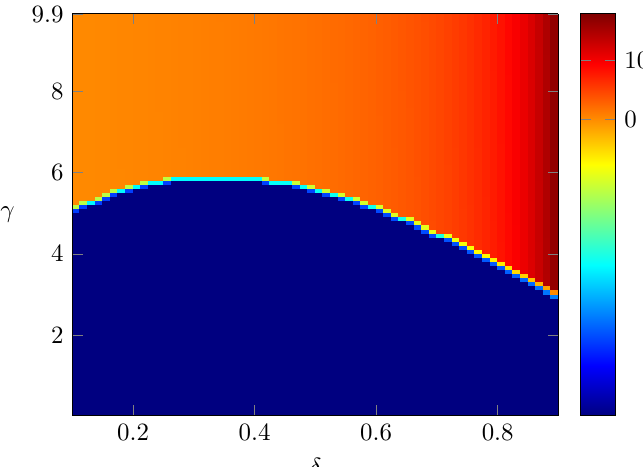
Figure 2. This shows C ∗ as a function of γ and δ . In the darker region in the bottom half of the plot, this is where ruin probability is always 1 regardless of the investment. In the upper half of the plot, the minimized ruin probability is less than 1 and it shows the heat map. Here, we take ρ = 2, ν = 2 and λ =